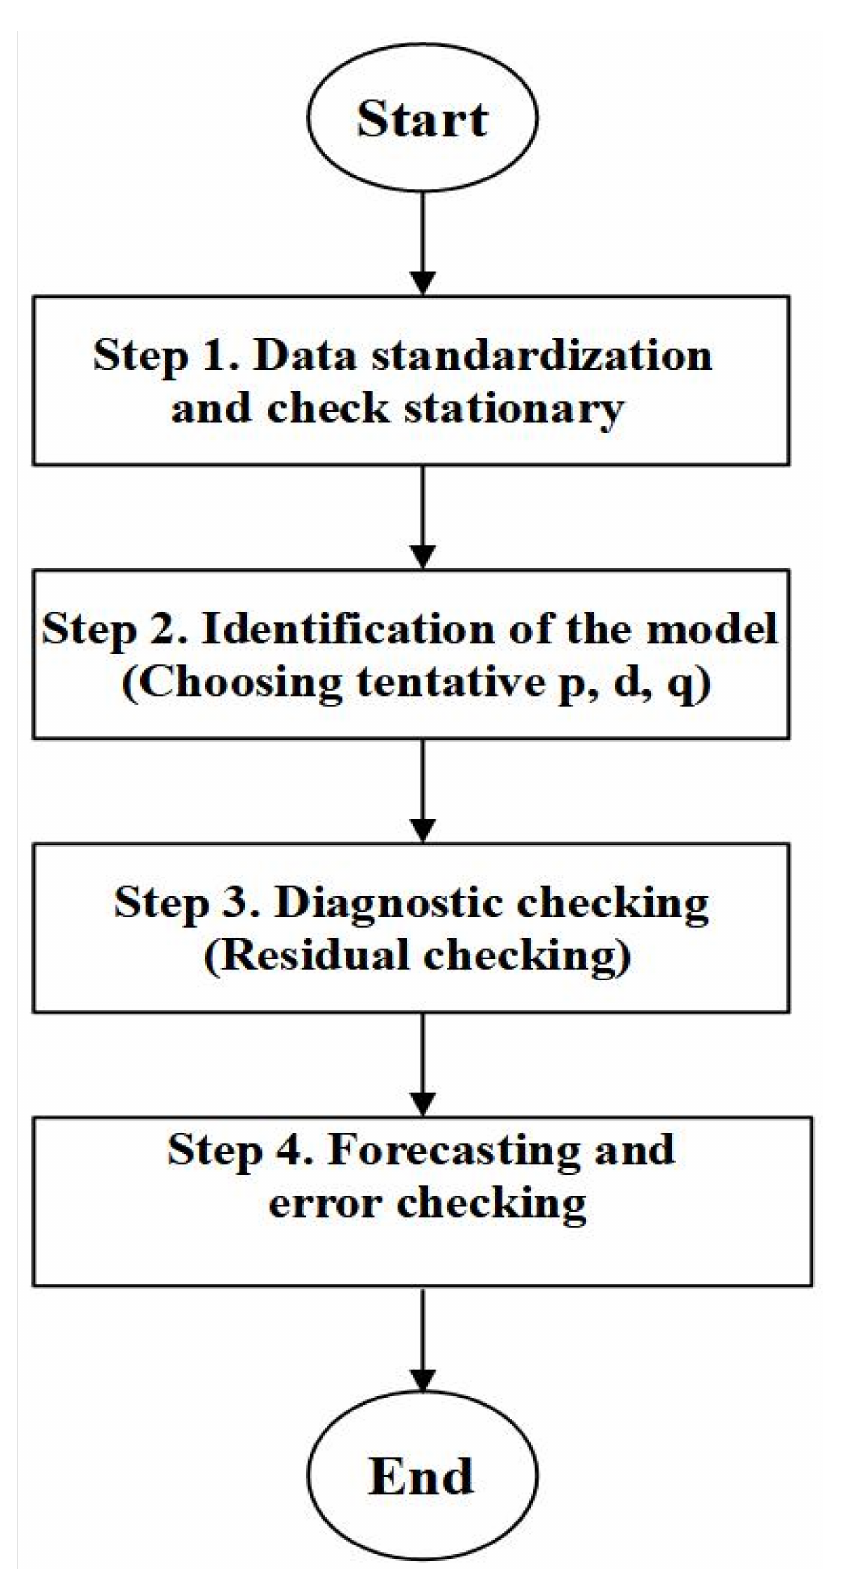
Figure 3. Model development in stochastic